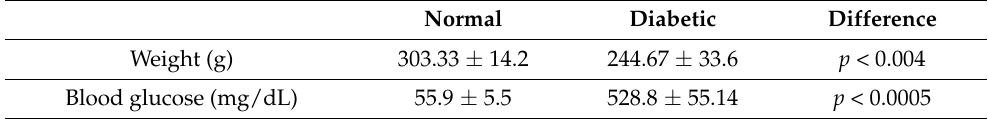
Table 1. Weight and blood glucose levels of normal and diabetic rats. Normal Diabetic